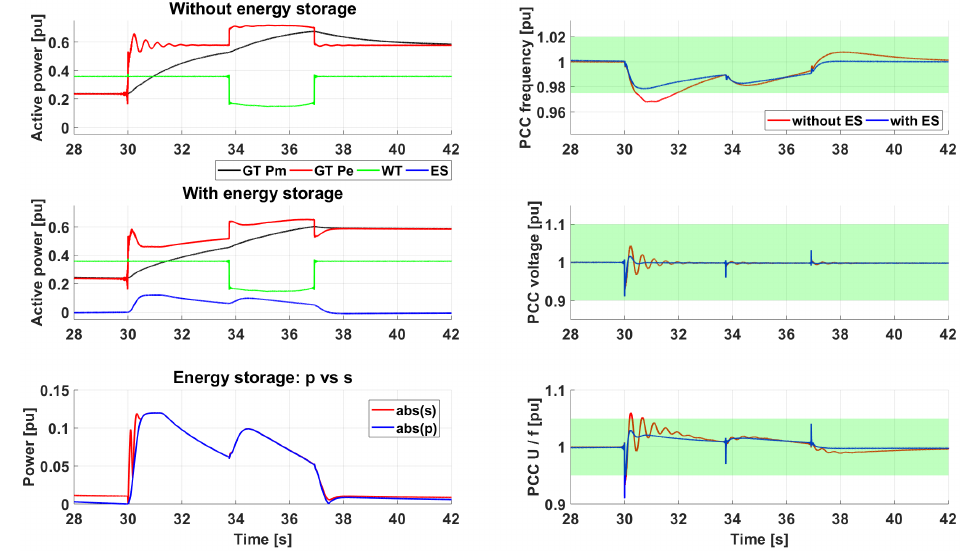
Figure 5. Detail of the period where a 10 MW load is switched on.